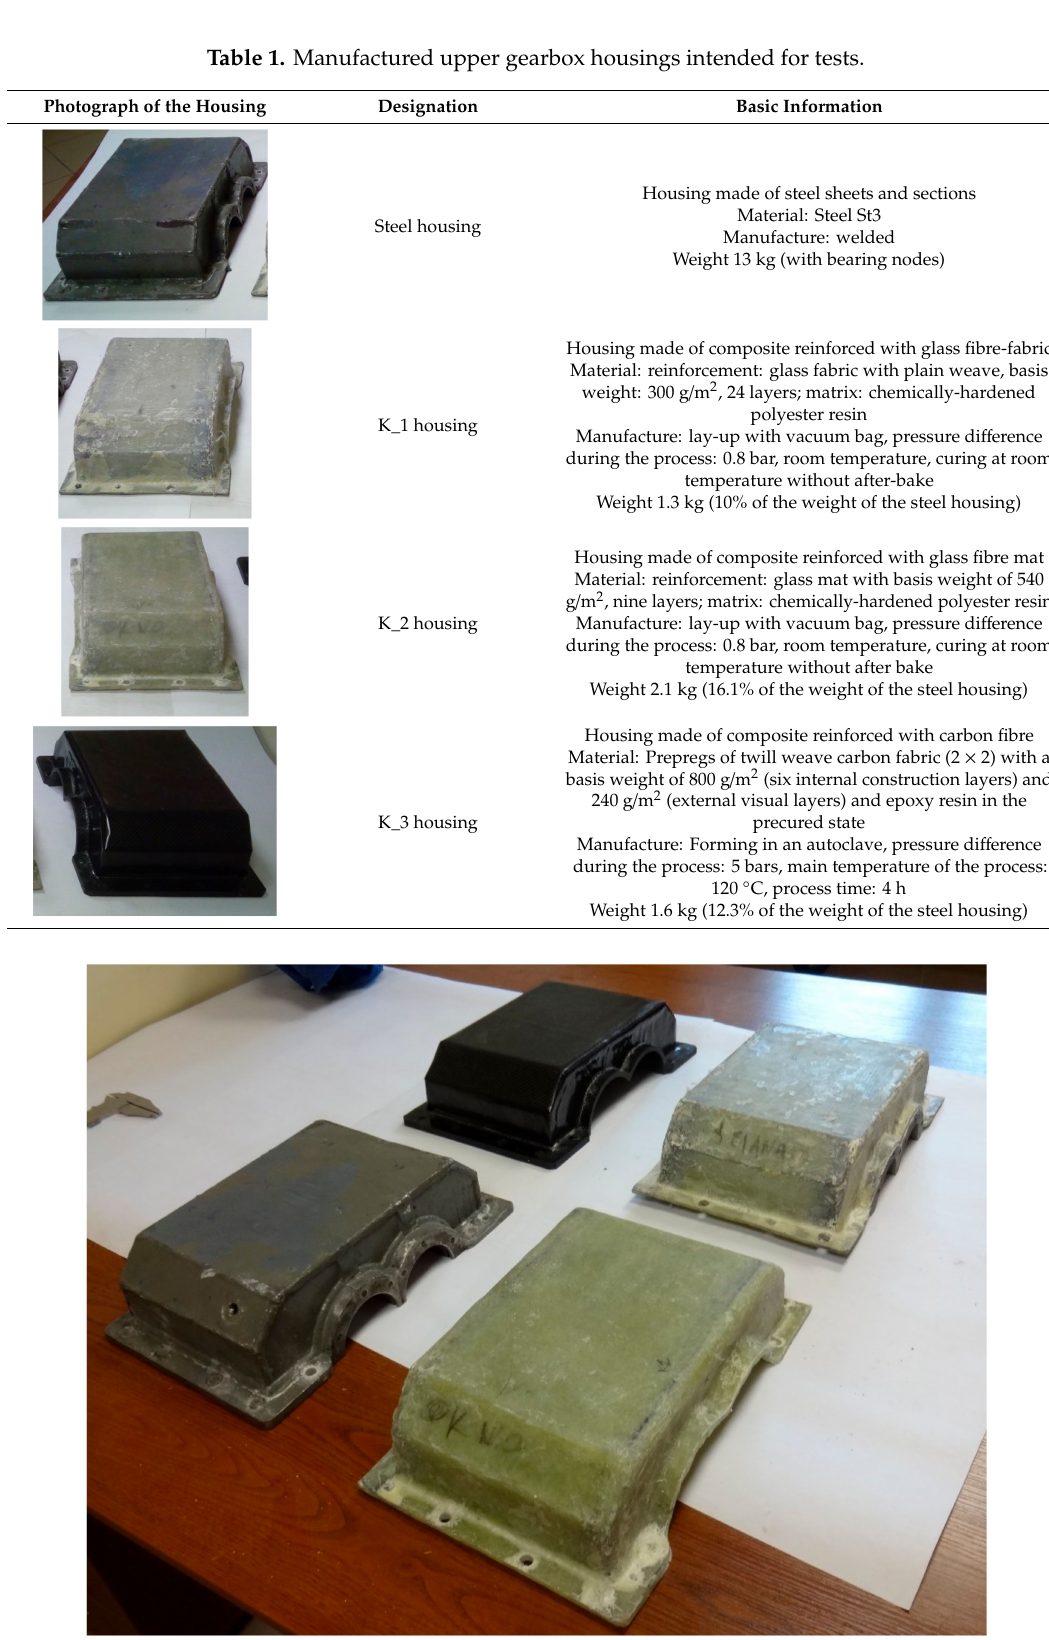
Figure 2. Steel housing (with bearing nodes) and composite housings before mounting bearing